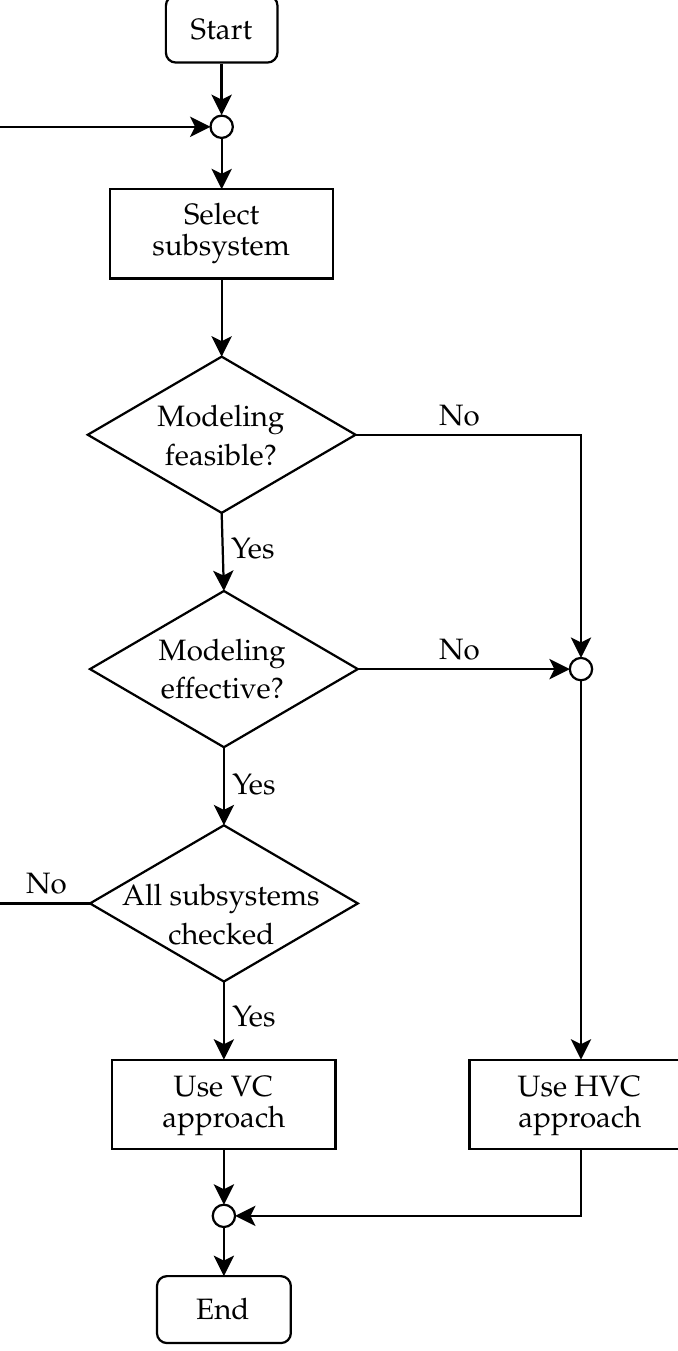
Figure 4. Flowchart of the proposed commissioning approach including HVC.